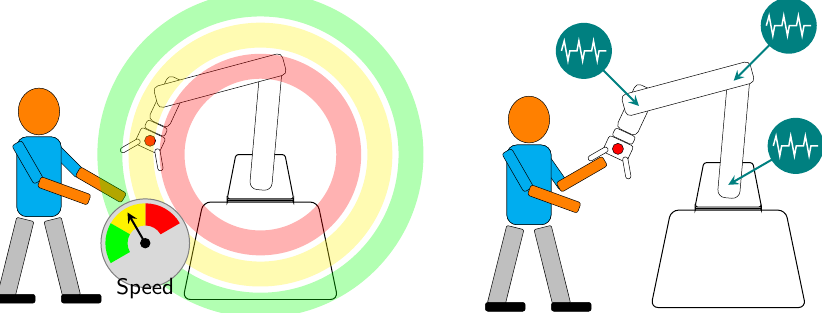
Speed Figure 5. Illustration of the two more complex levels of robot safety standards, as defined in norms ISO 10218-1 and 10218-2: the “Speed and separation monitoring” on the left and “Power and force limiting” on the